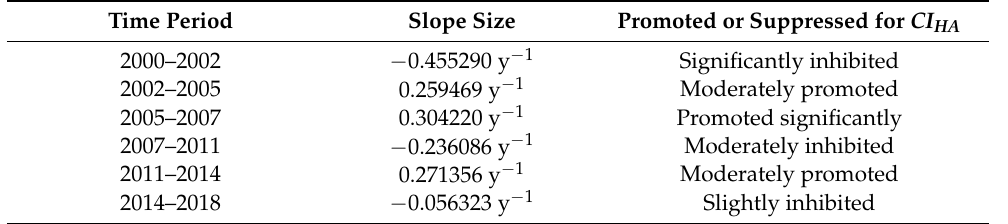
Table 8. Slope values of CI HA in different periods.